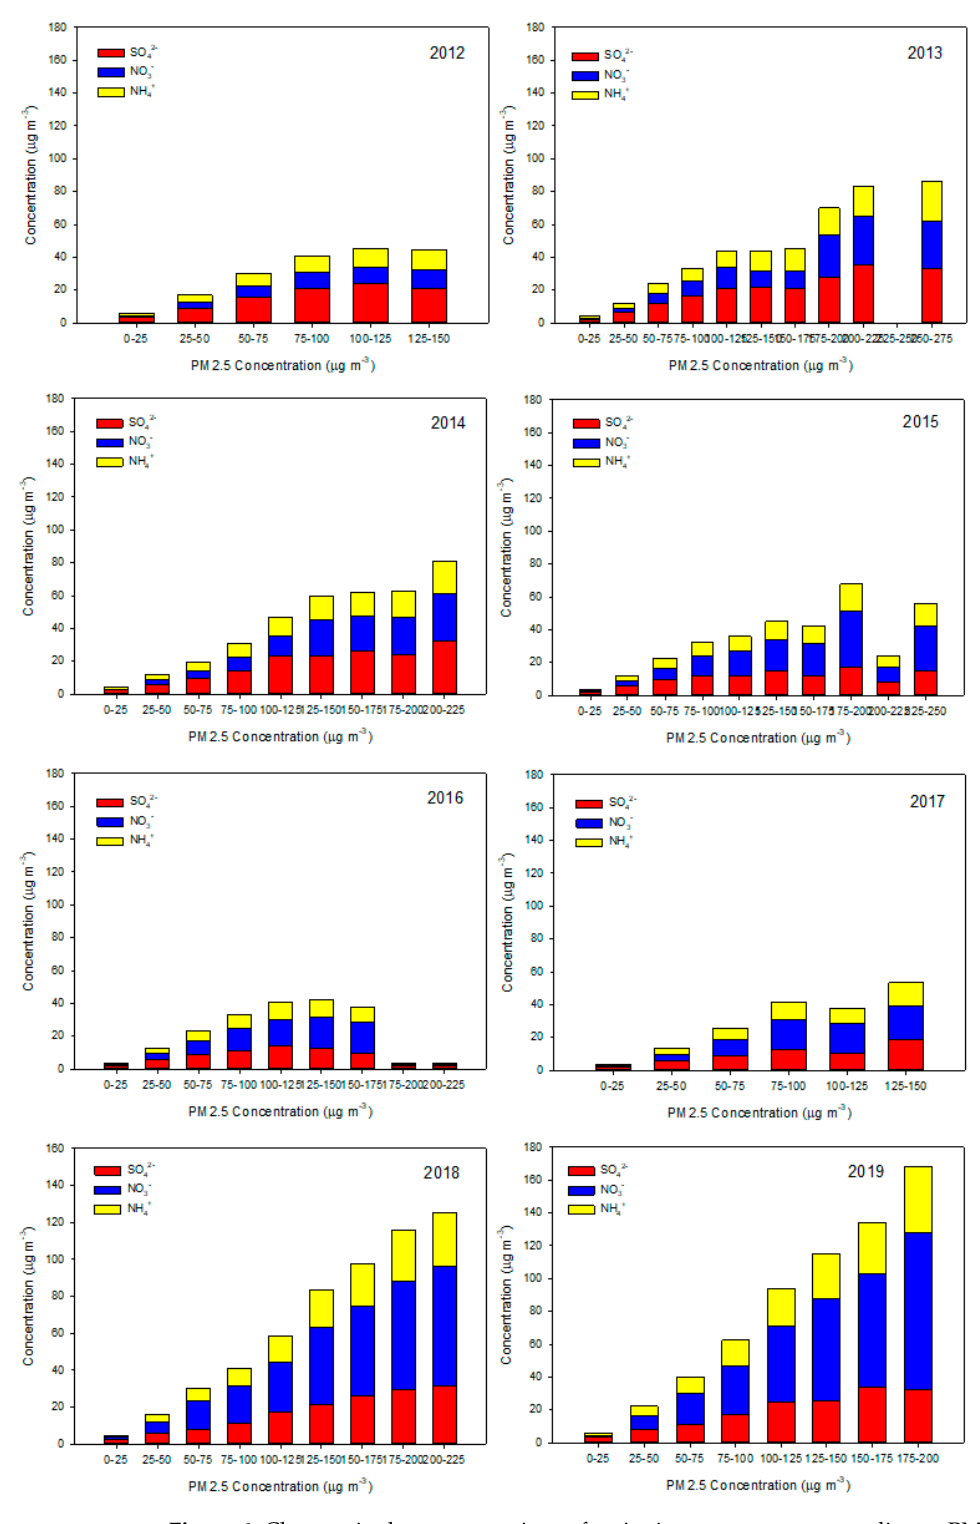
Figure 6. Changes in the concentrations of major ion components according to PM2.5 concentration on Baengnyeong Island.